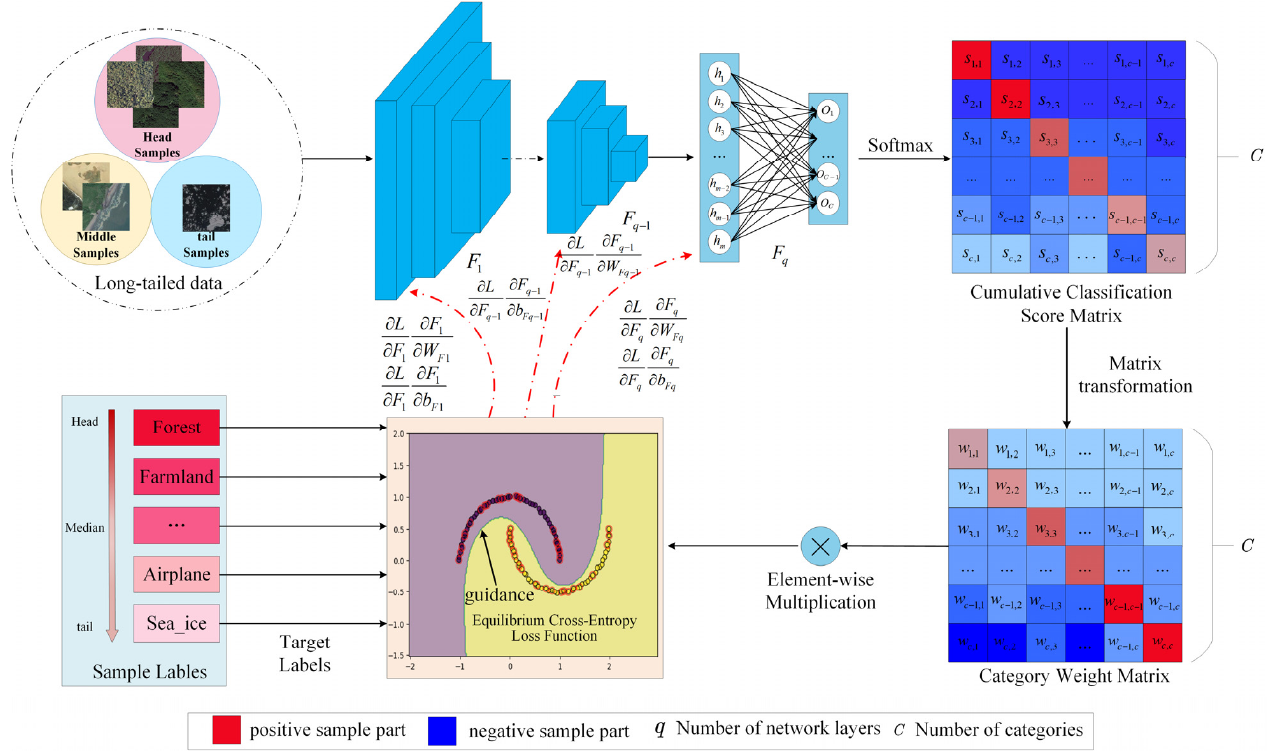
Figure 3. The overall structure of the proposed CCSMLW.